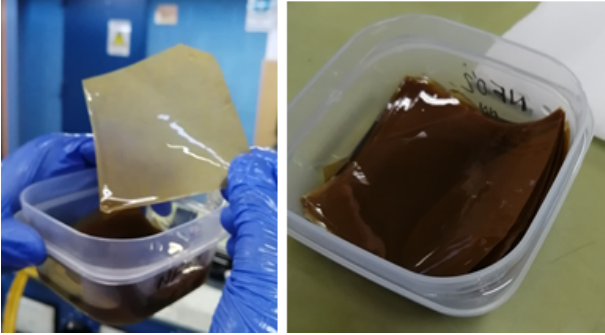
Figure 2. Oil-impregnated paper samples.